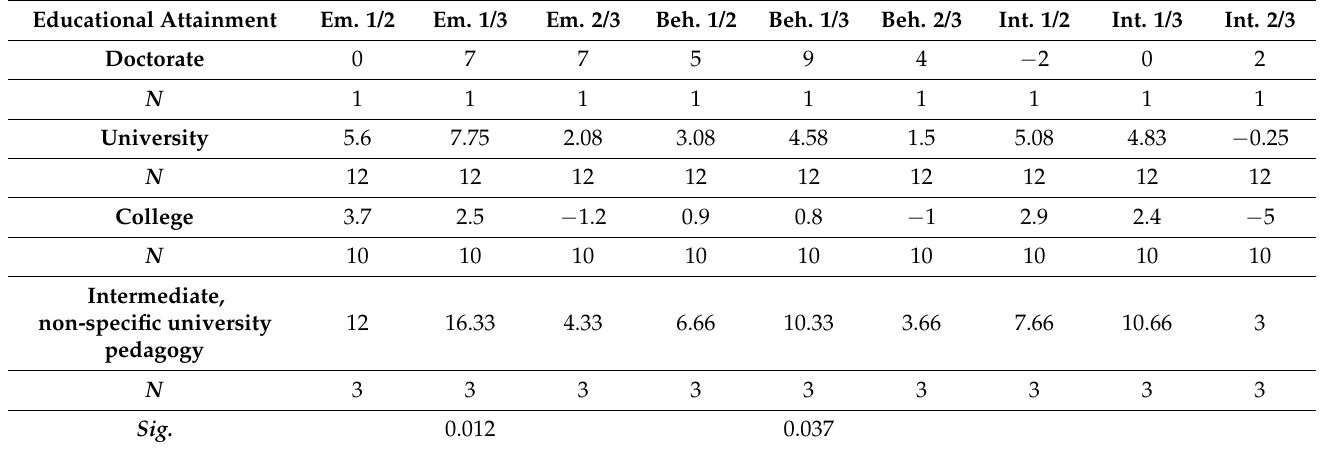
Table 5. Attitudinal change considering educational